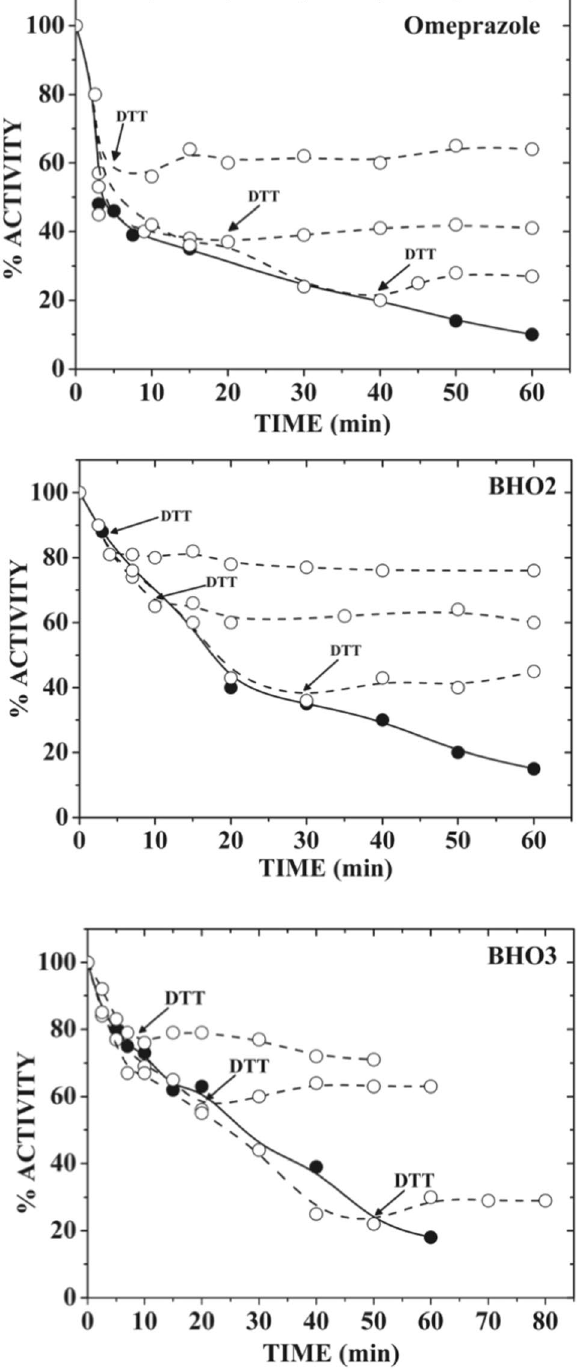
Figure 4. Failure of reactivation with reducing agent to derivatized GlTIM. GlTIM (200 µ g/mL) was incubated with the different compounds (1 mM) at 37 °C; at various times, aliquots were withdraw and the reaction stopped by dilution, then the remaining activity was determined as described in the Material and Methods section. In parallel assays, the GlTIM was also incubated with the compounds, but at different times it was added 1 µ L of DTT (5 mM final concentration) and the remaining activity monitored. The closed circles represent the control assay (i.e., without DTT treatment). Open circles represent the experiments with DTT treatment at different times. The arrows show the time in which DTT was added. The figures show representative experiments performed by